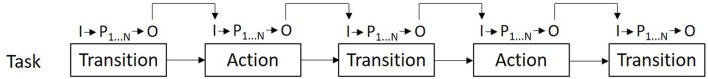
Teamwork episodes with repetitive IPO cycles (Marks et al., 2001).